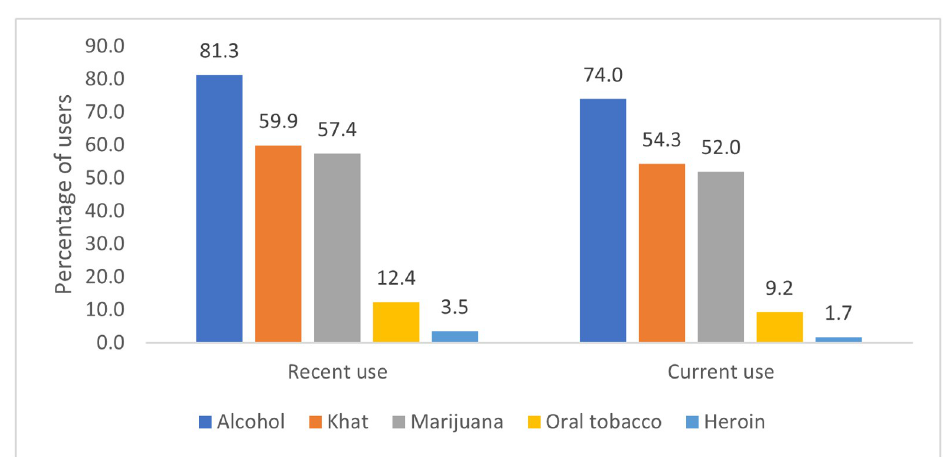
Fig 1. History of psychoactive substance use among young people in Kampala’s informal settlements.